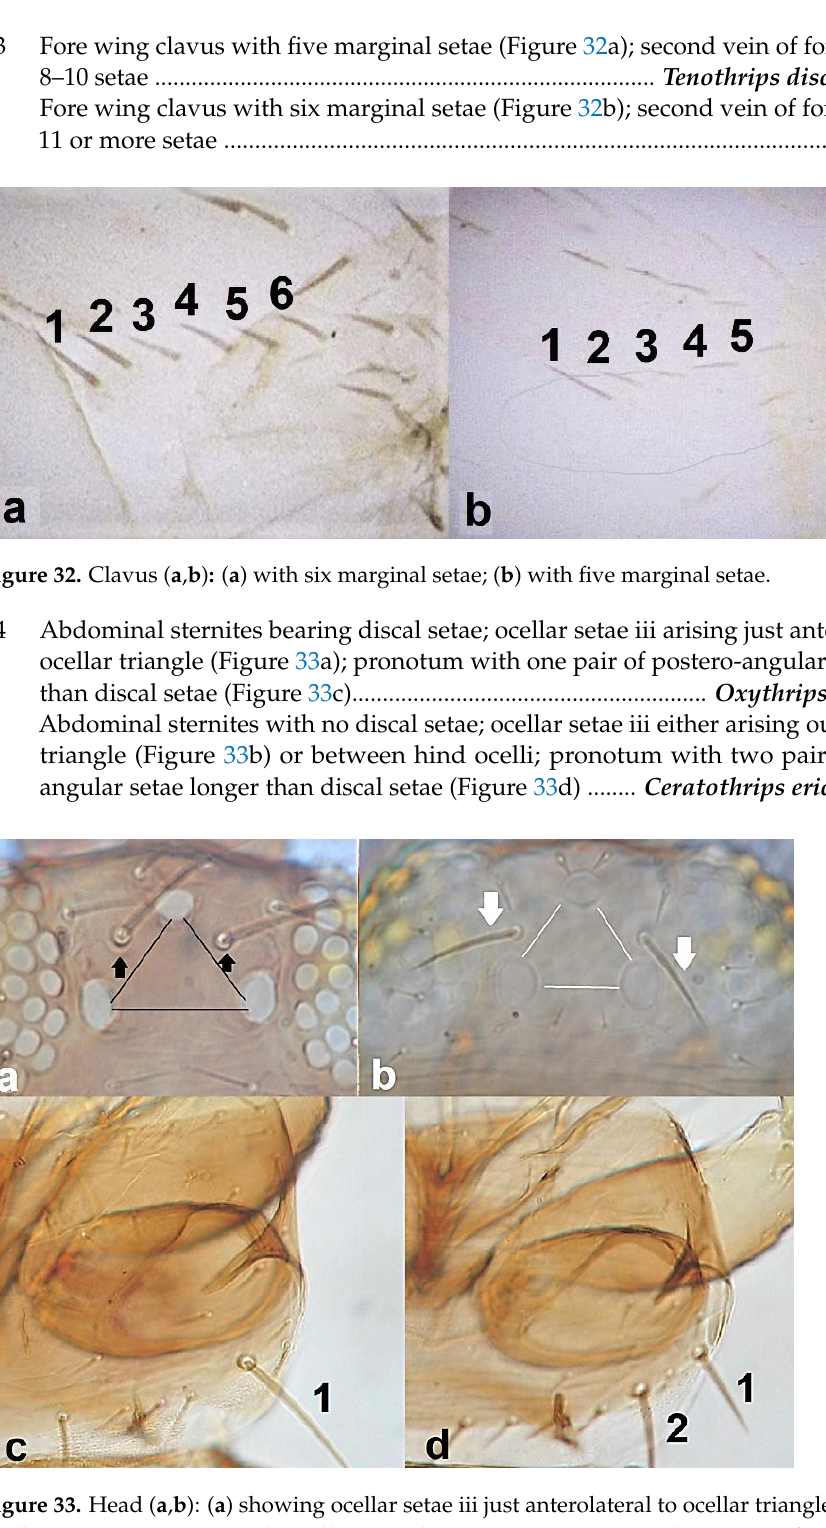
Figure 33. Head ( a , b ): ( a ) showing ocellar setae iii just anterolateral to ocellar triangle; ( b ) showing ocellar setae iii arising outside ocellar triangle; pronotum ( c , d ): ( c ) with one pair of postero-angular setae longer than discal setae; ( d ) with two pairs of postero-angular setae longer than discal setae.